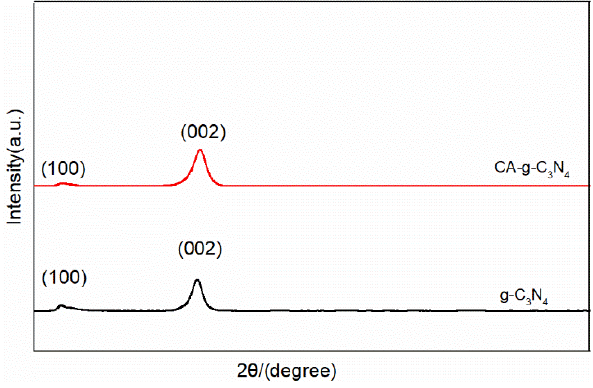
Figure 1. XRD patterns of g-C 3 N 4 and CA-g-C 3 N